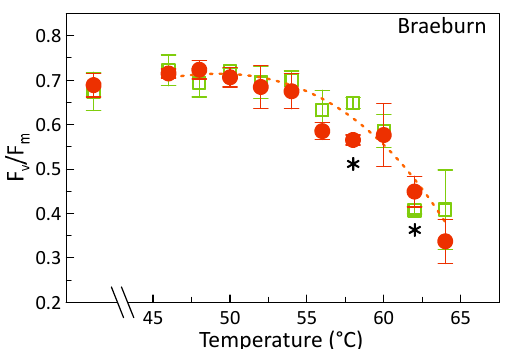
Figure 4. Means of the potential maximum photon yield of PSII (F v / F m ), pixel-averaged for each of the two sides (mostly red: filled circles; mostly greenish: open squares) of the fruit separately analyzed per ‘Braeburn’ sample (± SD, see bars; n = 3). The asterisks denote significant (Duncan’s test, p < 0.05) differences between means.